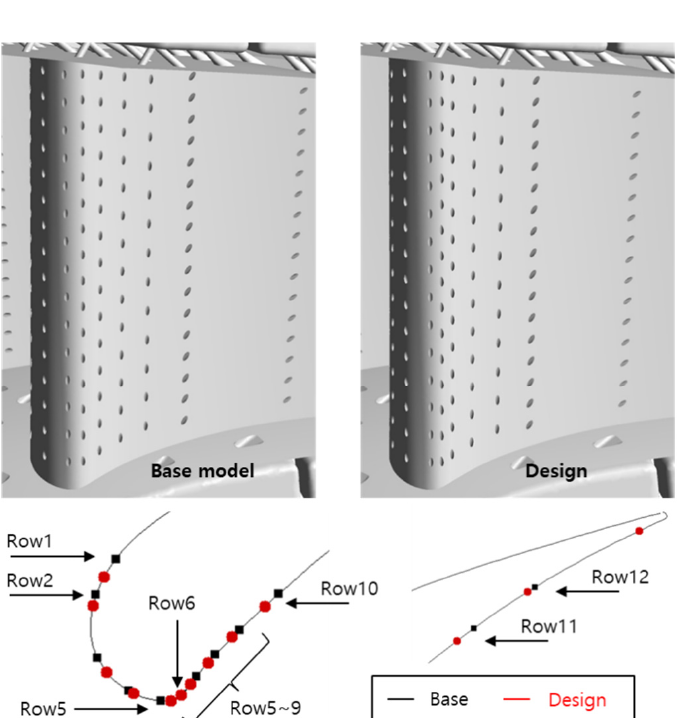
Figure 11. Comparison of cooling hole positions (adapted with permission from [16]; copyright 2021 Korean Society for Fluid Machinery).